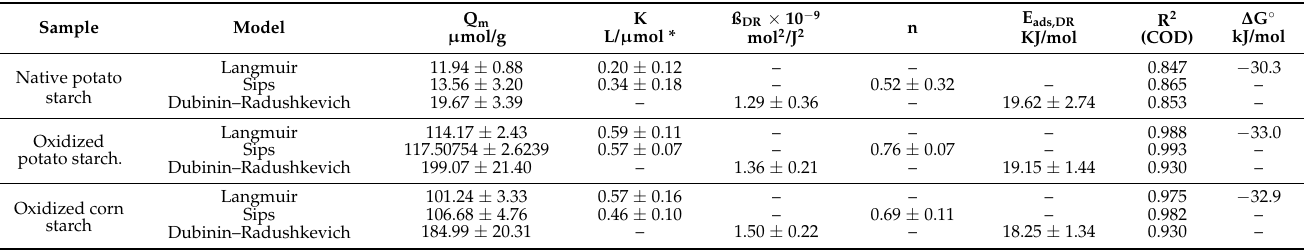
Table 2. Fitting parameters for the adsorption of Ni 2+ from NiSO 4 solution onto n. potato starch, o. potato starch and o. corn starch for Langmuir, Sips and Dubinin–Radushkevich isotherm models.